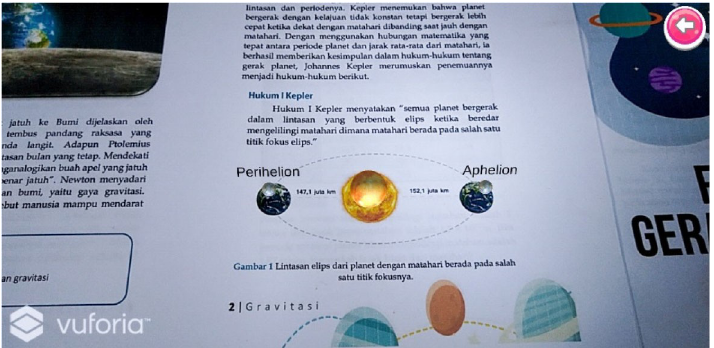
Figure 9. Projection of planetary trajectory 3D objects